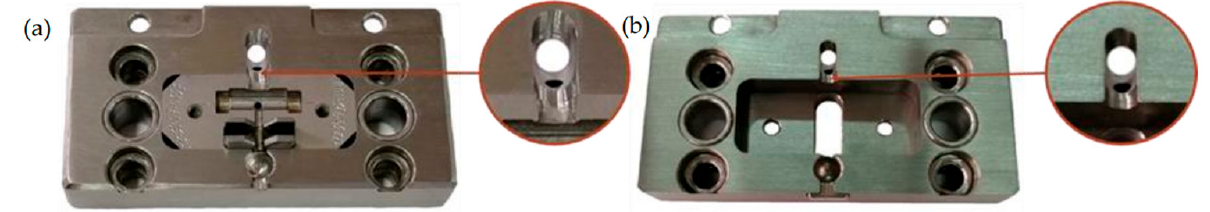
Figure 24. Structure of the molds before ( a ) and after changing the sprue channel geometry ( b ).